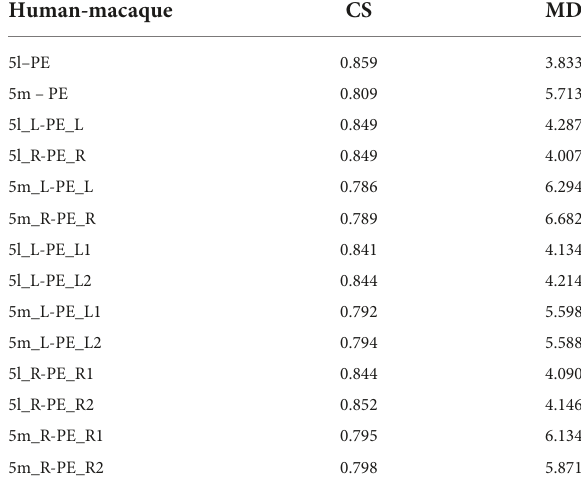
TABLE 5 Indication of CS and MD in resting-state functional connectivity fingerprints between human and macaque.